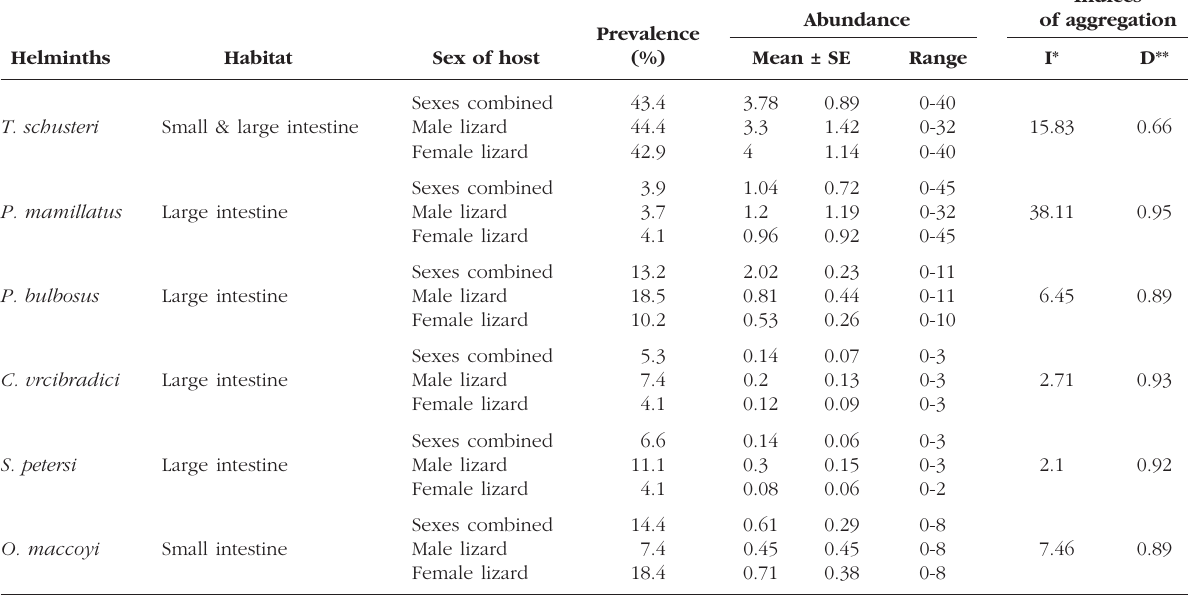
Table II. – Prevalence, abundance and indices of aggregation of intestinal helminths of Chalcides ocellatus collected from Egypt.